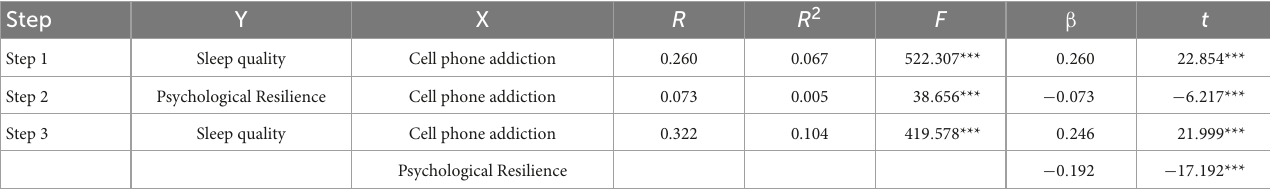
TABLE 5 Regression analysis of psychological flexibility on cell phone addiction and sleep quality among college students.